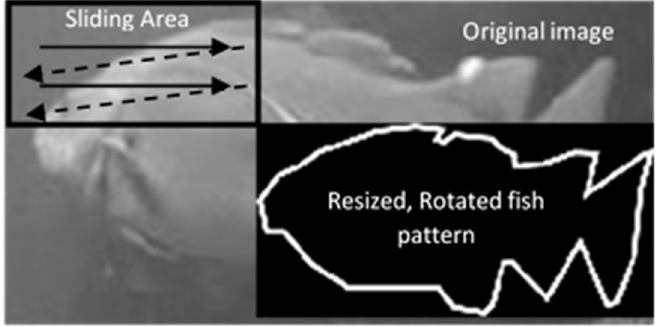
Algorithm 2 Pattern matching algorithm for the Contour2 approach